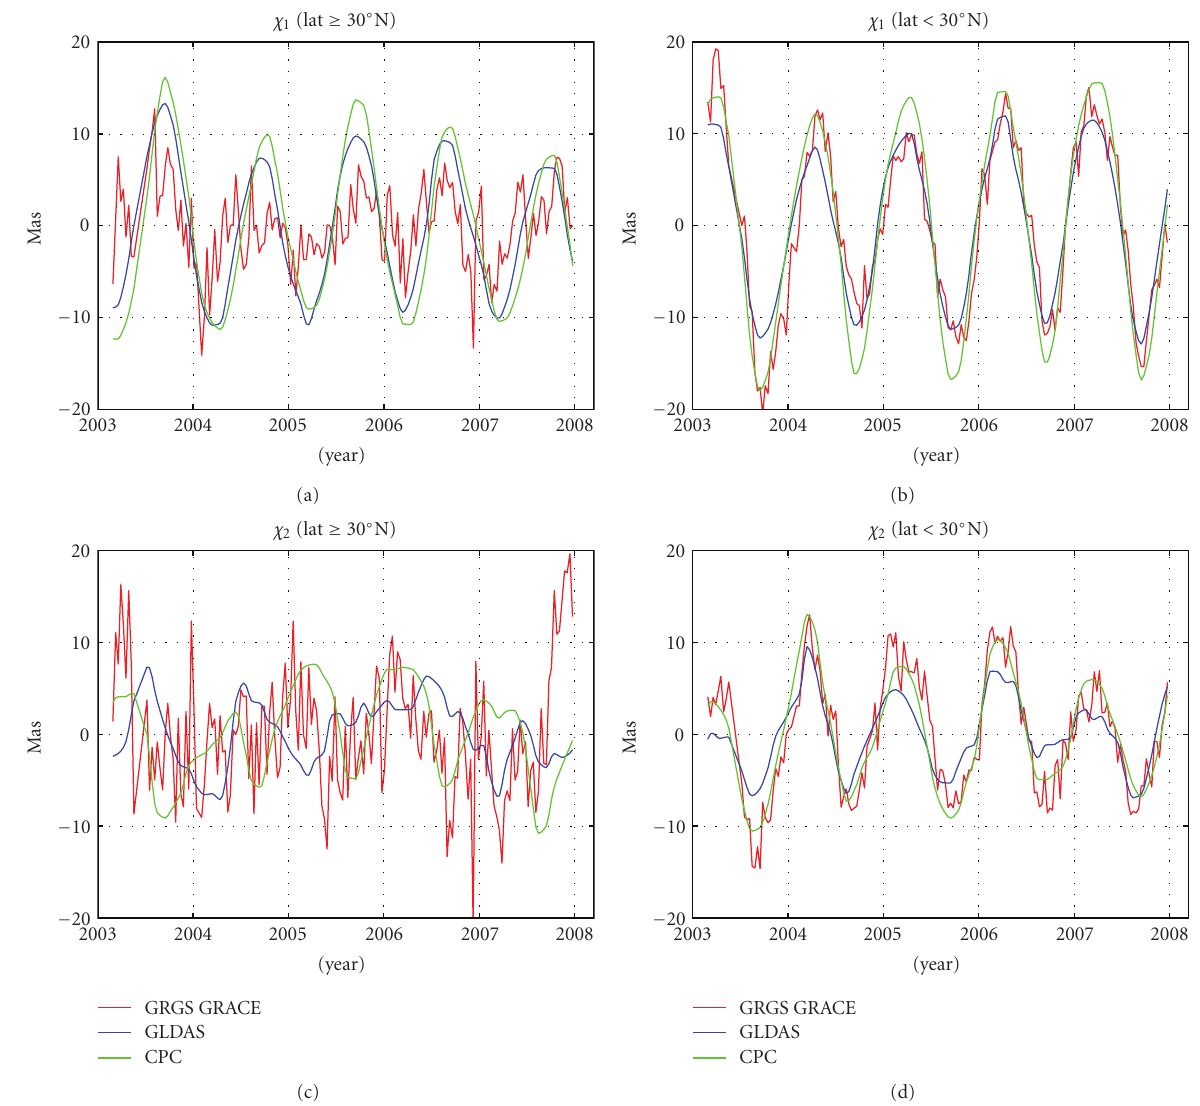
Figure 5: Polar motion excitations integrated over the Earth’s north high latitudes (latitudes ≥ 30 ◦ N ) and over the other latitudes (latitudes < 30 ◦ N ) using GRACE solutions and CPC and GLDAS models. Larger discrepancies between the models and GRACE observations come from the north high latitudes